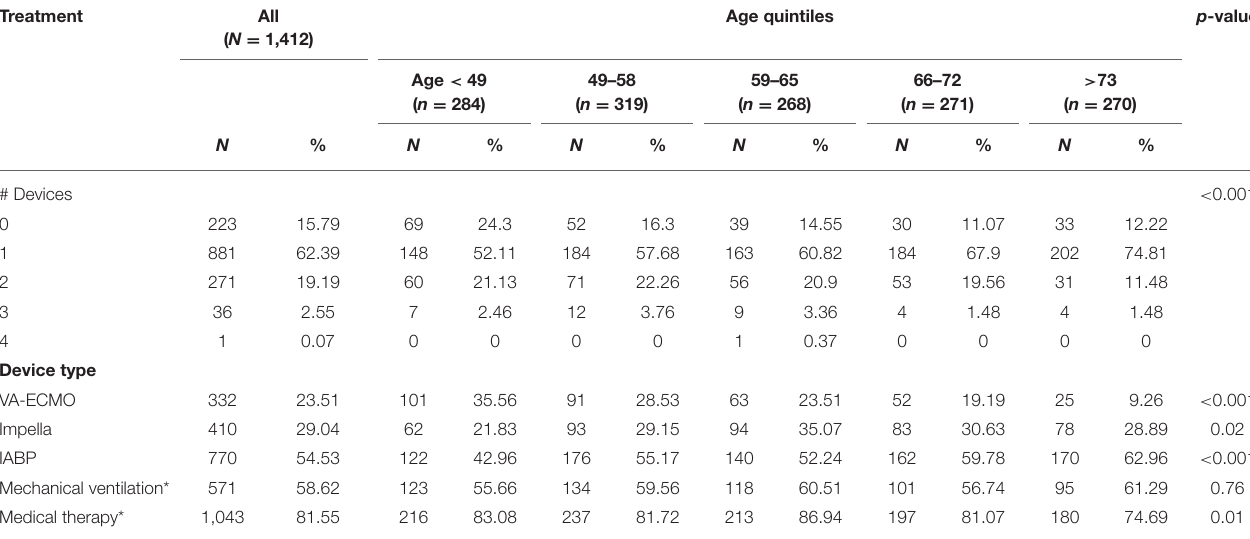
TABLE 3 | Device distribution across age quintiles. Treatment